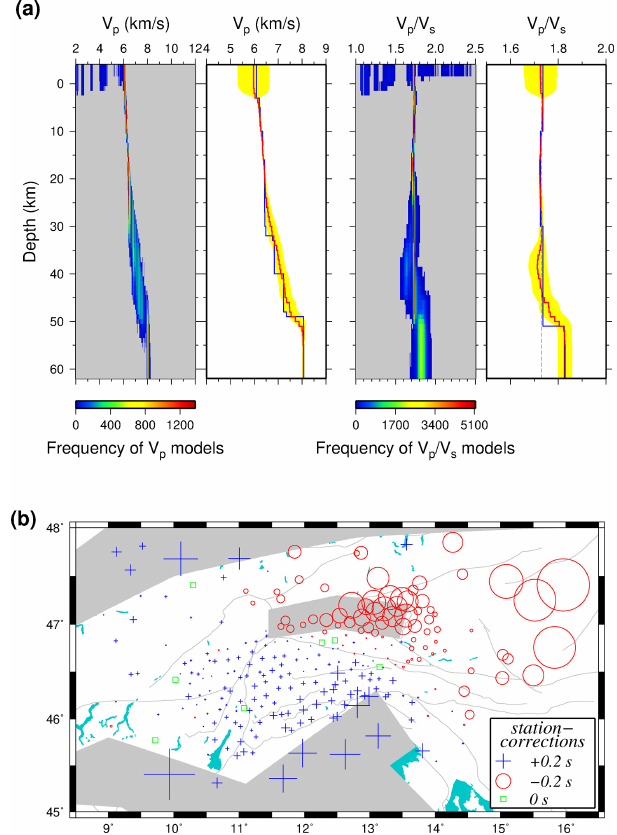
Figure 7. (a) Recovery of the V P and V P /V S models after the syn- thetic test. The results are shown with heat maps (probability his- togram vs. depth; warm and cold colors correspond to higher and lower probabilities, respectively) with gray areas showing zones with no model achievement. The modified average model (solid red line), most probable model (solid blue line), and corresponding un- certainty of 1 σ (yellow zone) for both V P and V P /V S models are √ 3 is displayed with the dashed shown as well. The V P /V S ratio of green line. (b) Recovered P wave station corrections of all the sta- tions that were involved in the McMC inversion. Blue crosses show positive values reflecting lower velocities, and red circles display negative values indicating higher velocities than expected. Regions indicated in gray have shallow high- or low-velocity anomalies (see Fig. 5 for more information). Symbol size corresponds to correction amplitude. The faults are same as Fig. 2.